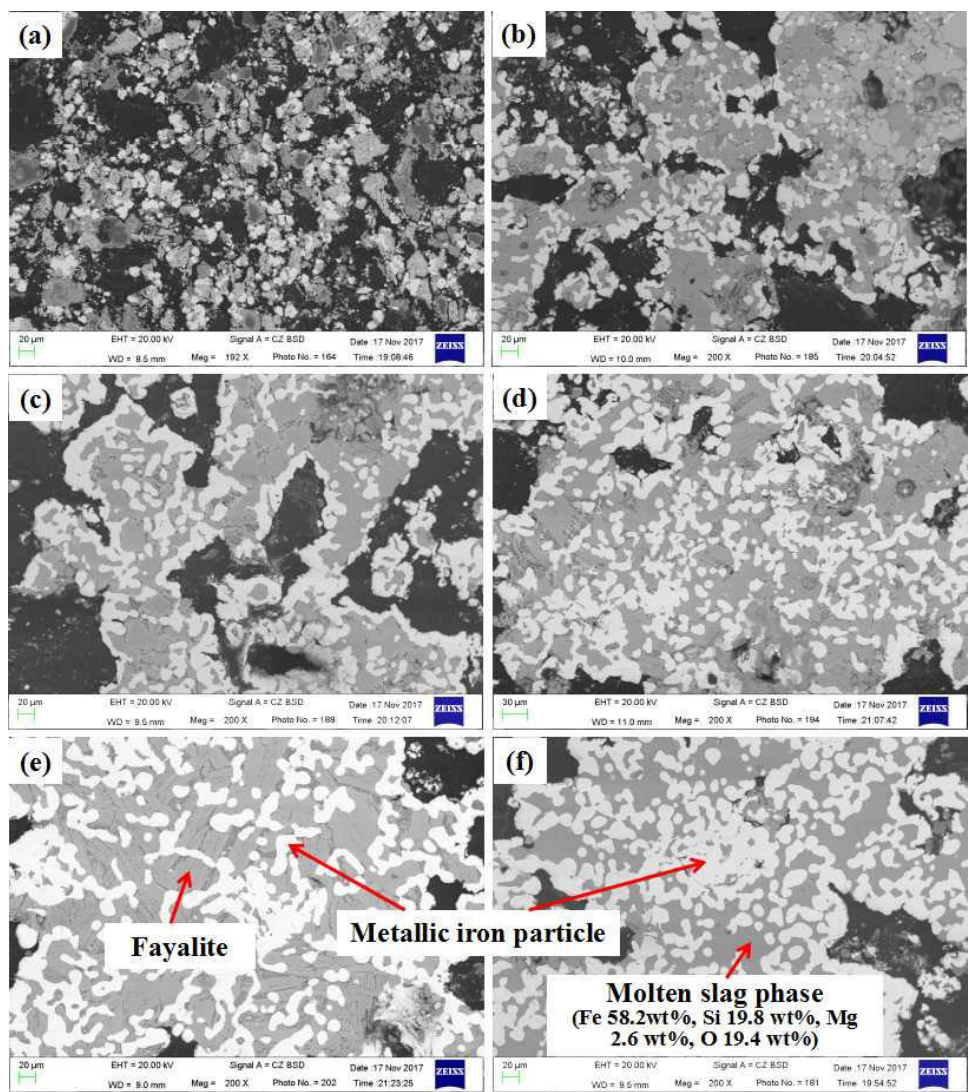
Figure 13. Microstructure of the pellets reduced at 1200 °C: at ( a ) 7.5 min, ( b ) 10 min, ( c ) 12.5 min, ( d ) 15 min, ( e ) 20 min, and ( f ) 25 min.